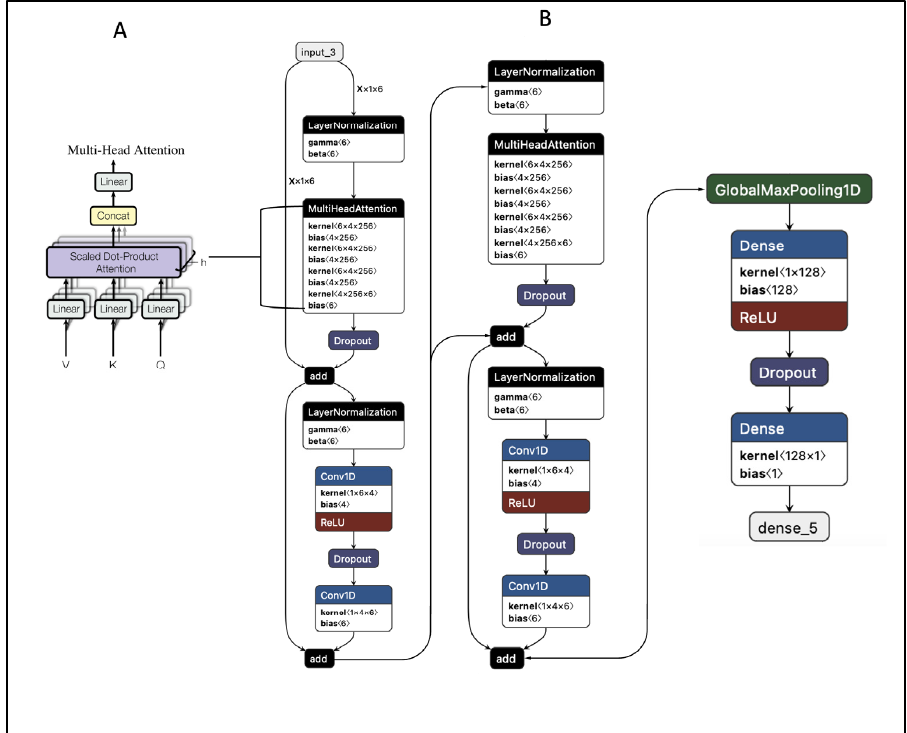
Figure 4. The architecture of implemented Transformer model. ( A ) Multi-Head Attention structure.